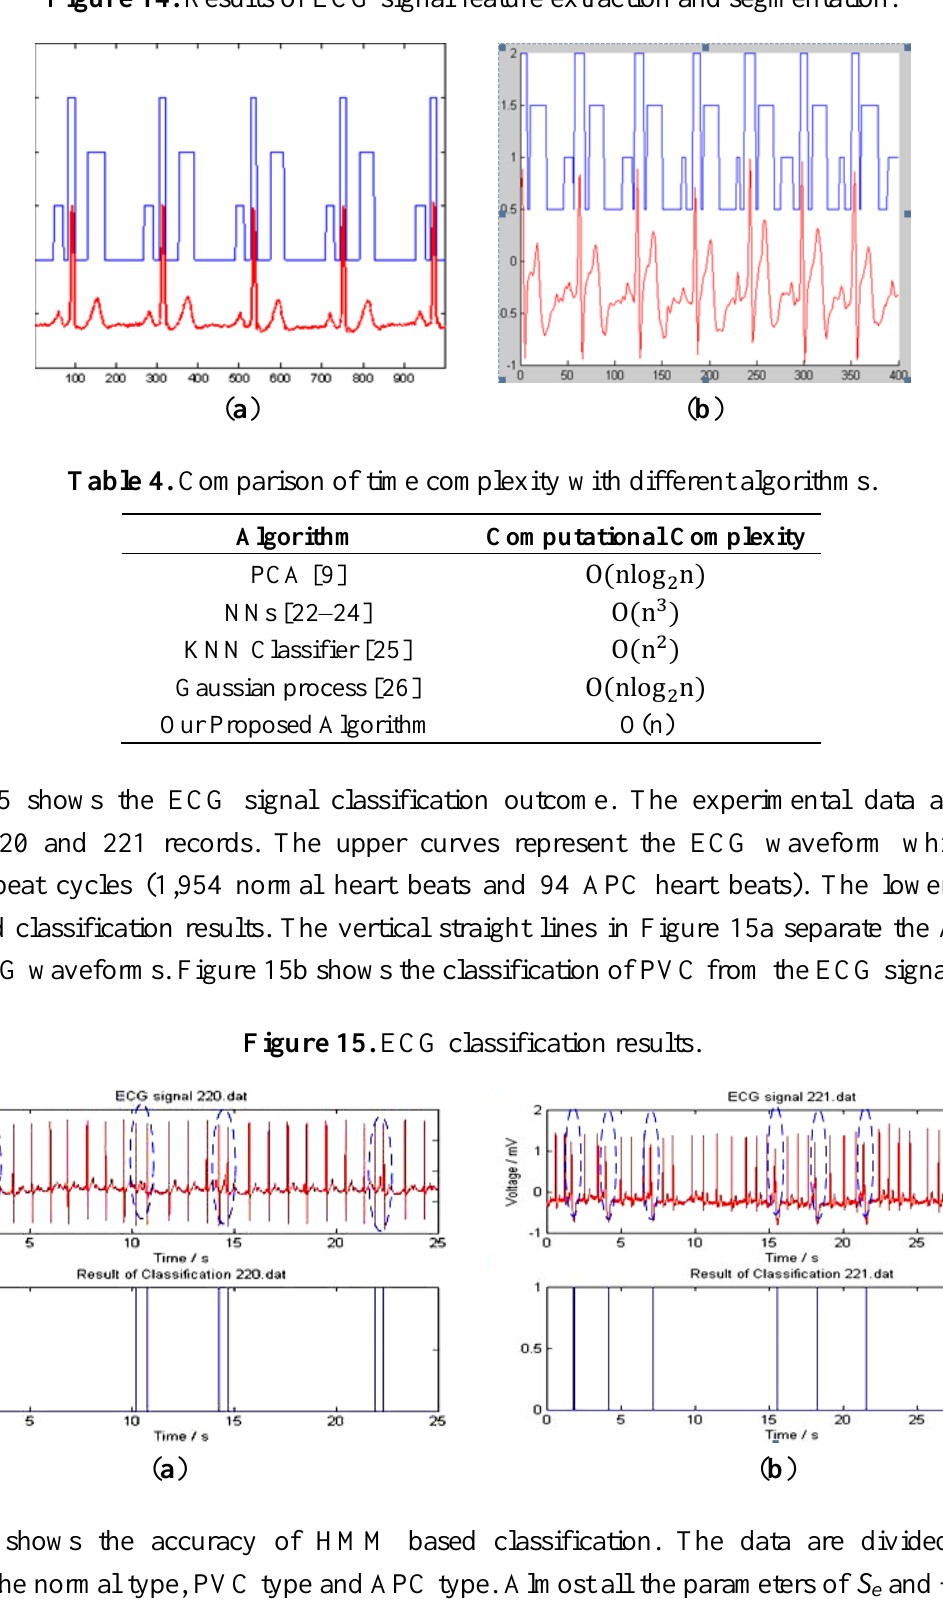
Figure 14. Results of ECG signal feature extraction and segmentation.